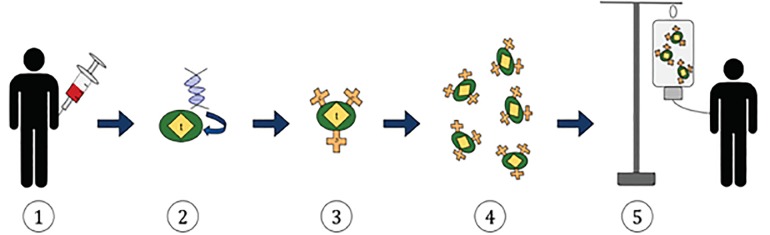
Chimeric antigen receptor (CAR) T-cell therapy process1) T cells present in the blood are removed from the patient. 2) These T cells are incorporated with the gene-encoding specific antigen receptors. 3) This results in CAR receptors present on the surface of T cells. 4)These modified T cells are harvested and grown in a laboratory setting. 5) The engineered T cells are finally administered to the original patient.Modified from https://commons.wikimedia.org/wiki/File:CAR_T-cell_Therapy.svg. Accessed April 7, 2019.